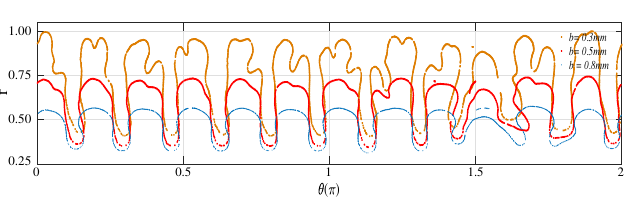
Figure 6. Plots of the 0.5 concentration contour for M = 3, U = 10 mm/s in the polar coordinates ( r , θ ) at b = 0.3 mm, 0.5 mm and 0.8